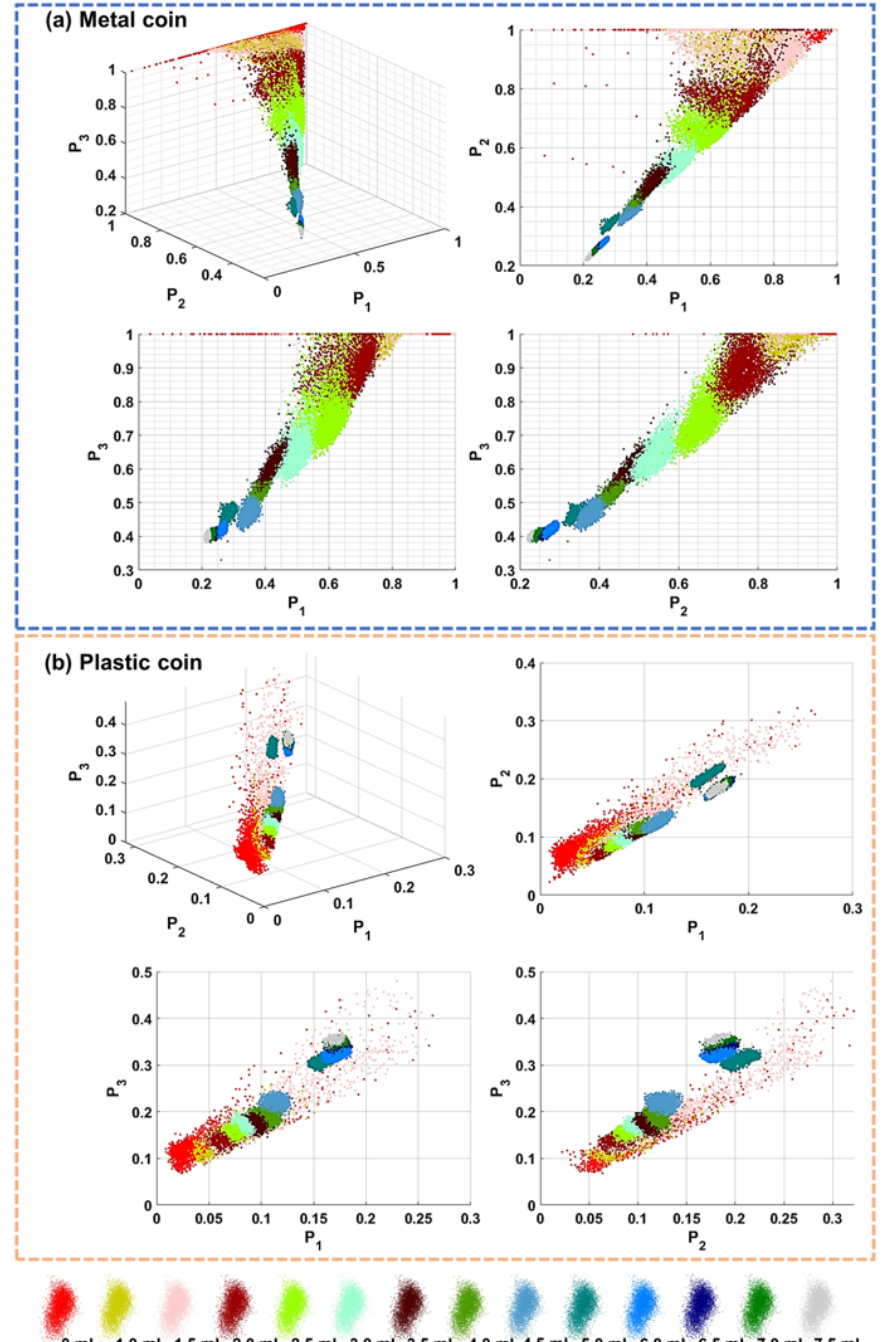
Figure 7. IPPs values change when varying the turbidity of scattering media: ( a ) metal coin and ( b ) plastic